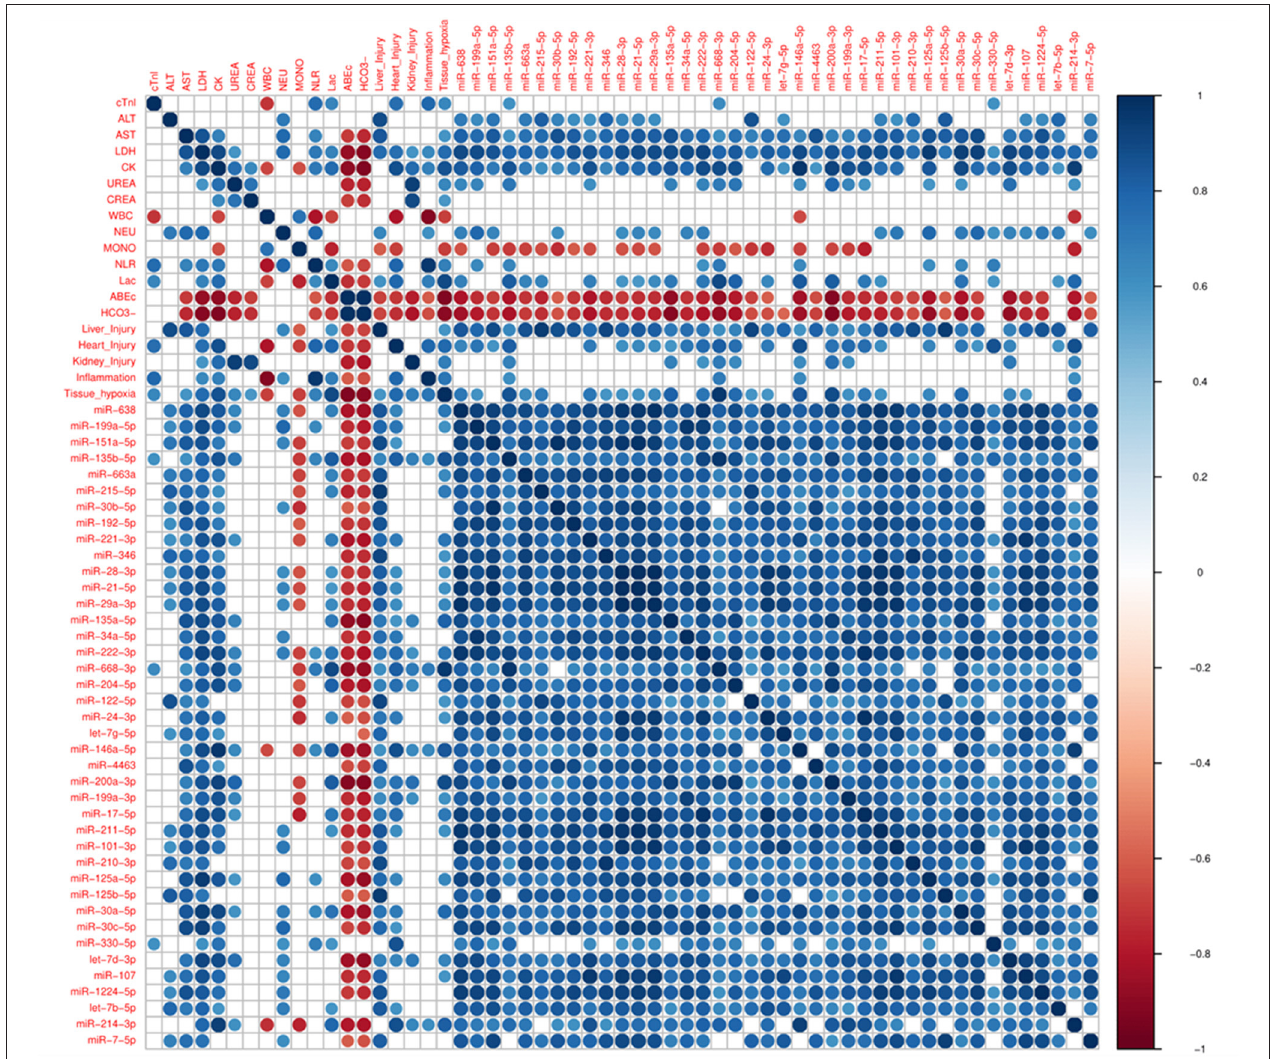
FIGURE 2 | Corrplot with Spearman’s correlations between pathological changes in the blood (PCB) and circulating miRNAs induced by THS with p < 0.01 ( n = 40 miRNAs). All significant ( p < 0.05) correlations are indicated as circle. Positive correlations are displayed in blue and negative correlations in red color. Color intensity and the size of the circle are proportional to the correlation coefficients